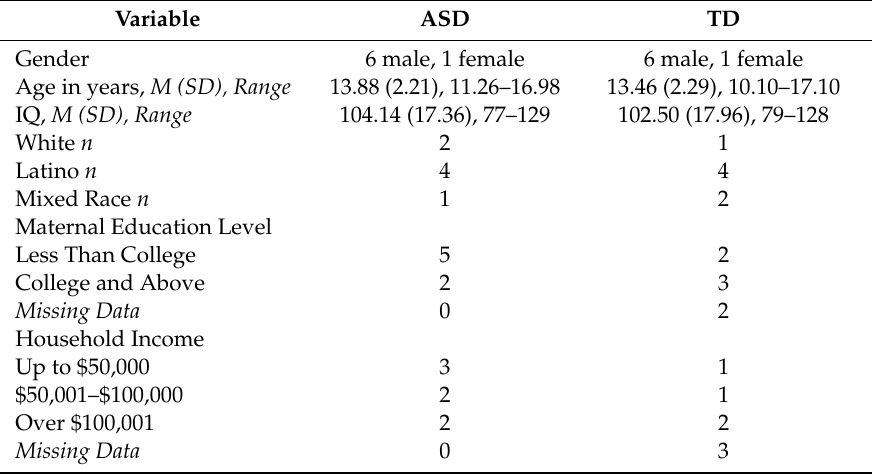
Table1. Descriptivecharacteristicsoftheautismspectrumdisorder(ASD)andneurotypical(TD)groups. Variable ASD TD Gender 6 male, 1